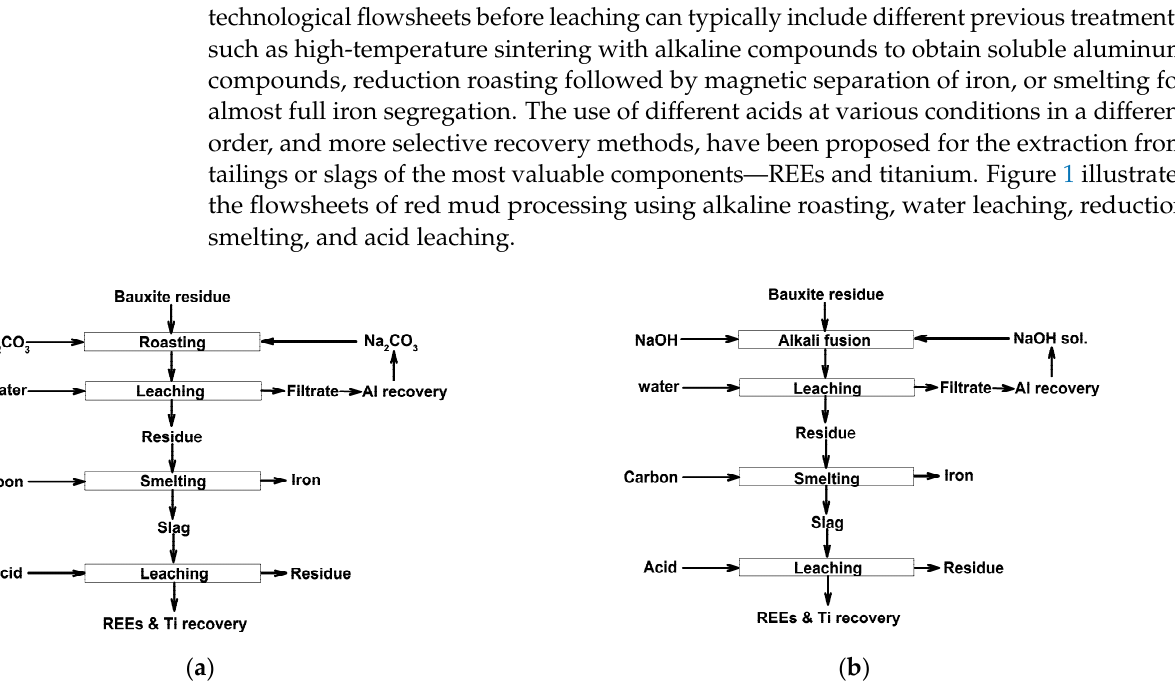
Figure 1. The schematic diagrams of metals recovery from red mud via alkaline roasting–water leaching–reduction withNa 2 CO 3 ( a ) or NaOH ( b ) as an alkaline agent. Adopted from [83].